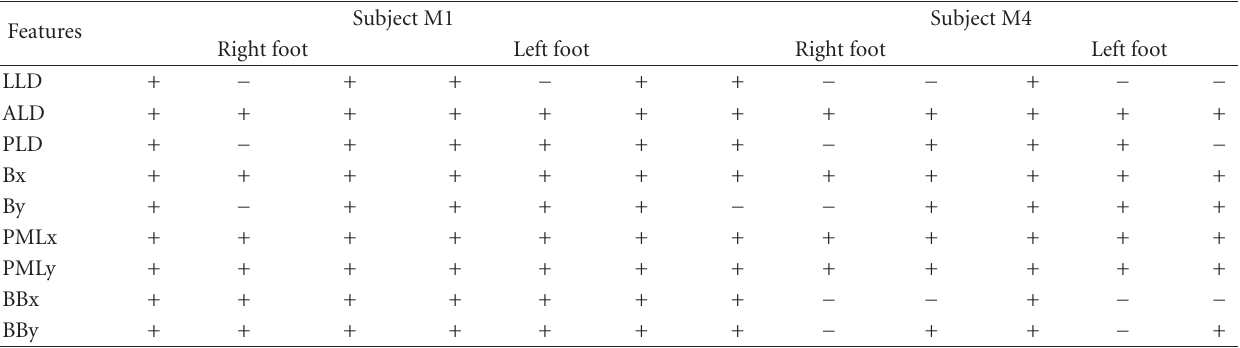
Table 4: Student’s t -test analysis of the features in male subjects F1 and F4 during 3 sessions with the 2D guide ( P > . 000125 → “+,” P < . 000125 → “ − ”).